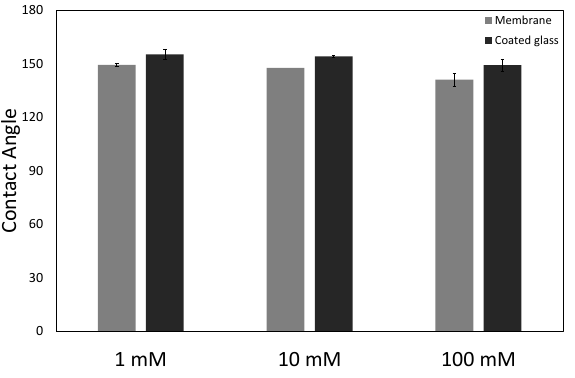
Figure 3. Contact angles of sodium dodecyl sulfonate (SDS) stabilized hexadecane droplets on cellulose coated glass and cellulose based ultra-filtration (UF) membranes as measured with the captive bubble method with 1, 10 and 100 mM NaCl. Error bars represent the standard deviation after